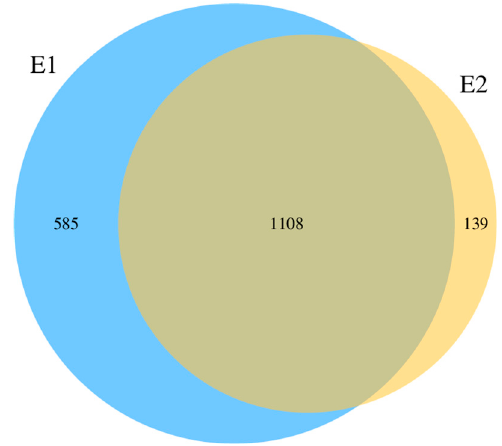
Figure 8. Venn diagram based on the OTUs of the substrates.